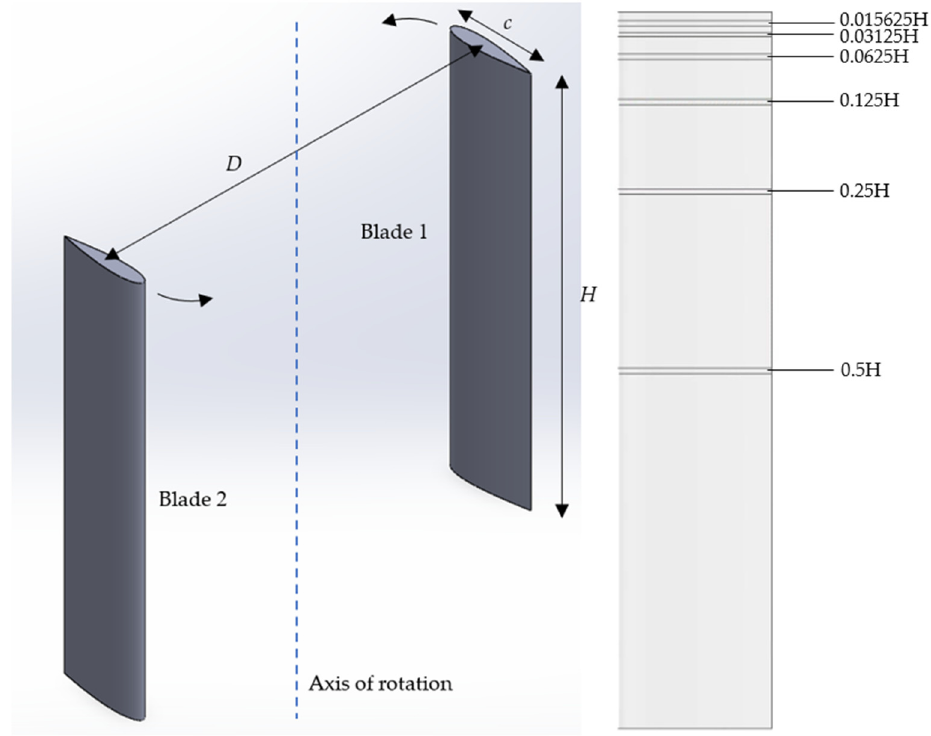
Figure 1. NACA0018 straight-bladed VAWT and cut sections adopted in the current